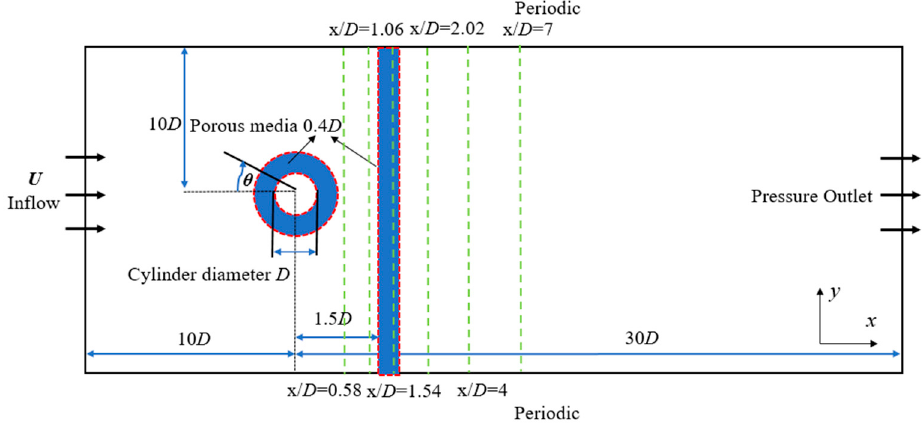
Figure 1. Schematic of the computational domain for flow pass a cylinder.